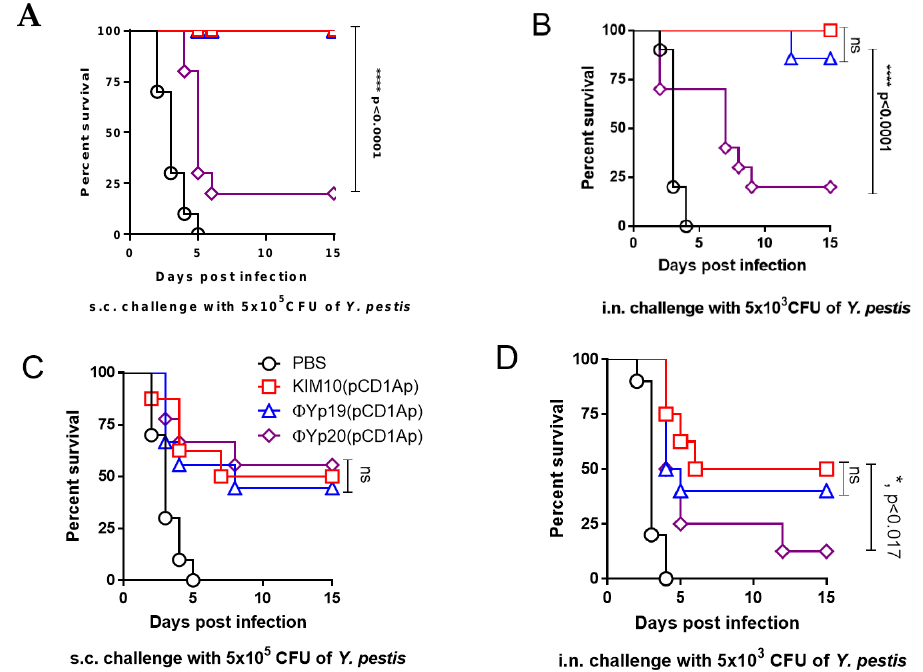
Figure 3. Mouse survival after Y. pestis KIM6 + (pCD1Ap) challenge. Mice that survived after i.m. or s.c. administration were pooled and split evenly for s.c. and i.n. challenge of virulent Y. pestis